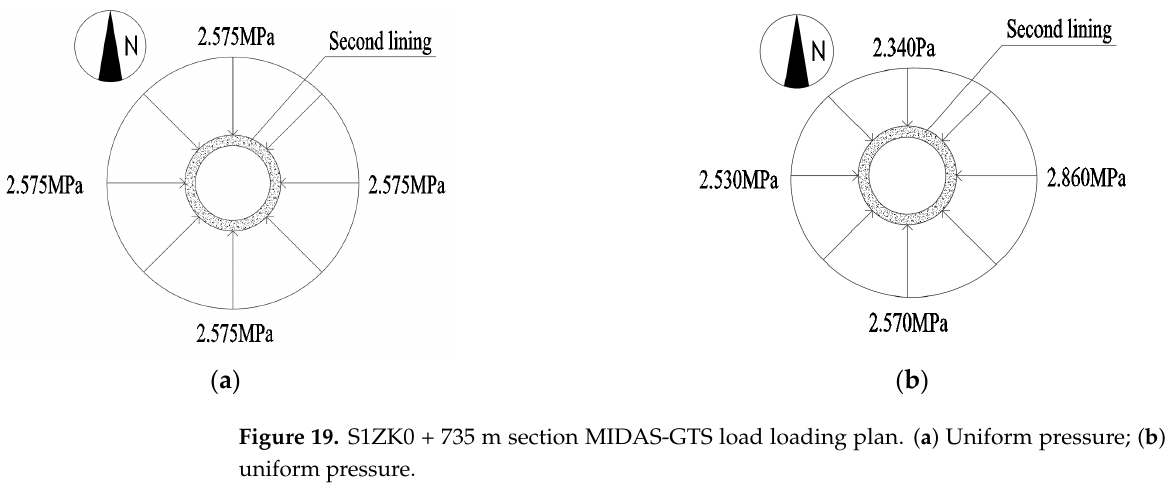
Figure 18. S1ZK0 + 660 m section MIDAS ‐ GTS load loading plan. ( a ) Uniform pressure; ( b ) Non ‐ uniform pressure.